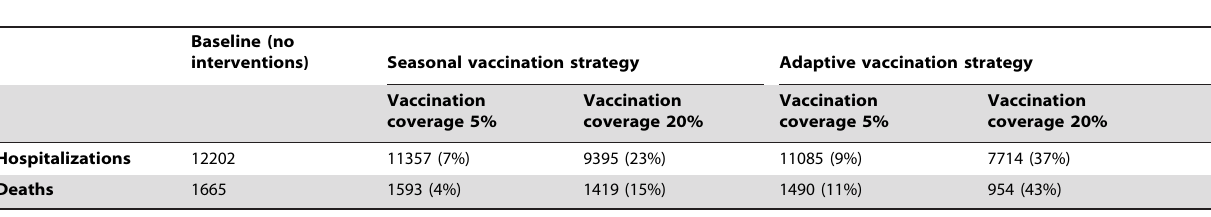
Table 2. Comparison of predicted rates (per 100,000 people) of hospitalizations and death in the context of the 2009 S-OIV outbreak in Mexico, for various concurrent vaccination strategies.